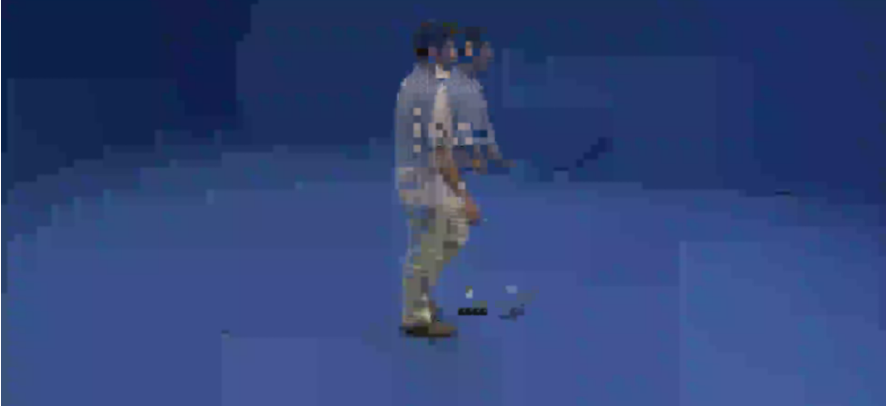
Figure 8. Frame of a video with a bitrate of 40 Kbps: Accuracy = 0.99.